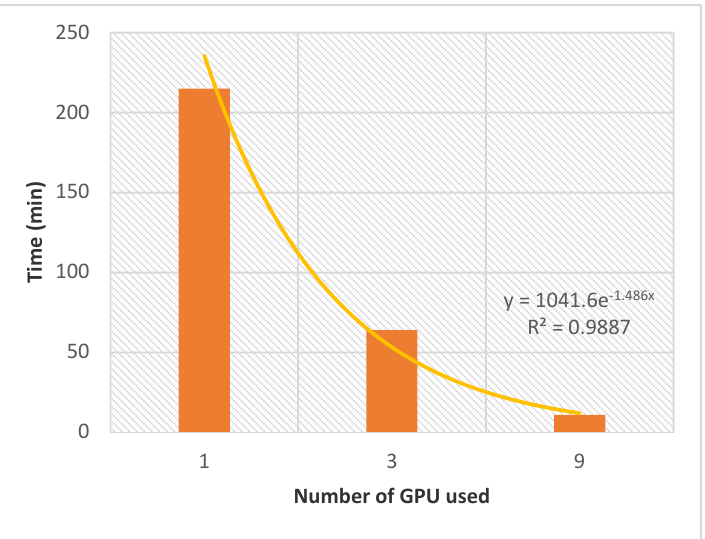
Figure 4. Evolution of the time needed to complete the double screening as a function of the number of GPUs. The experiments were realized with AMIDE v2, between the set of 9 ligands and the T. gondii dataset. The number of docking experiments per box was set to 20.